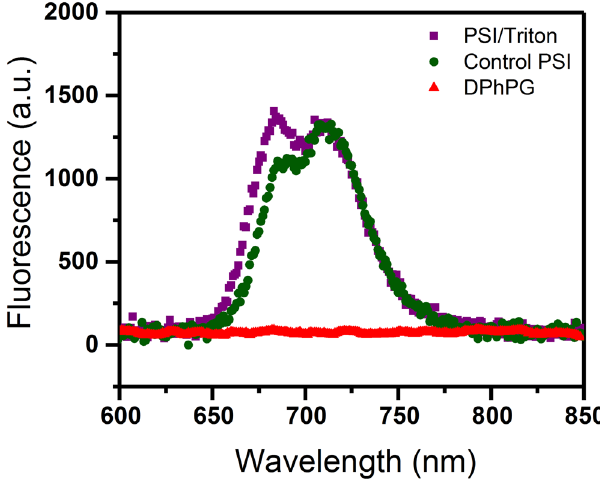
Figure 7. Room temperature fluorescence emission spectra of DPhPG liposomes, TX-100 solubilized PSI, and control PSI